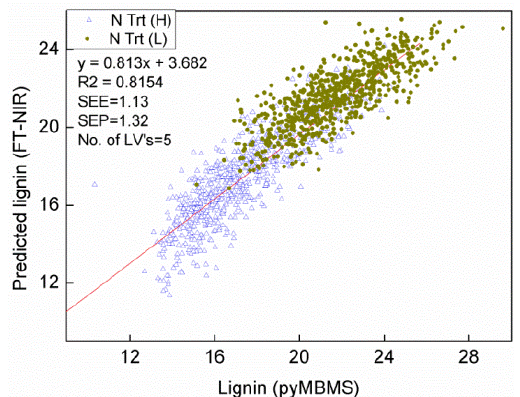
Figure 1. Pyrolysis molecular beam mass spectrometry (pyMBMS) vs . Fourier transform near infrared (FT-NIR) predicted lignin for low and high nitrogen